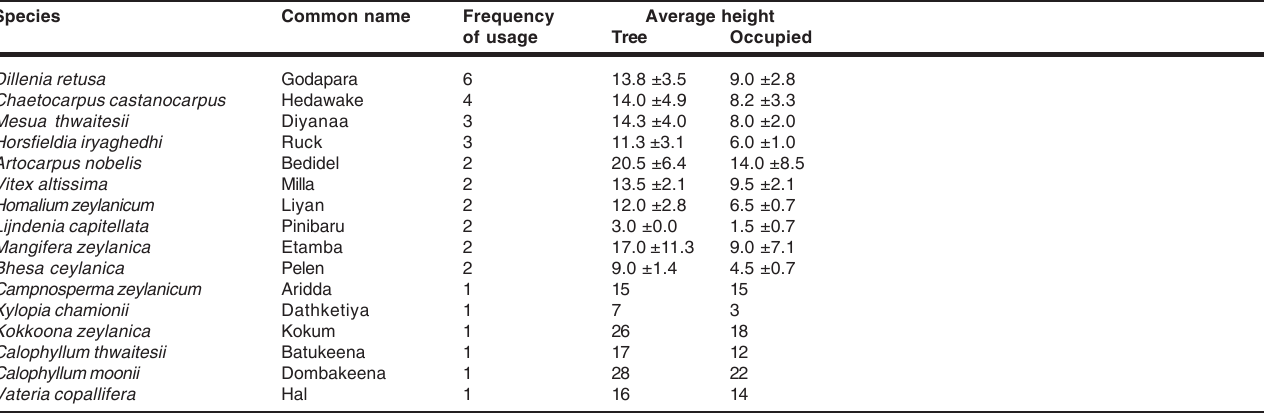
Table 2. Frequency and percentage at which Slender Lorises were encountered on different plant species (n = 34)